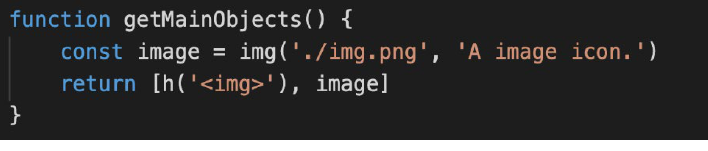
Figure 9. Implementation of the getMainObjects function to create an image